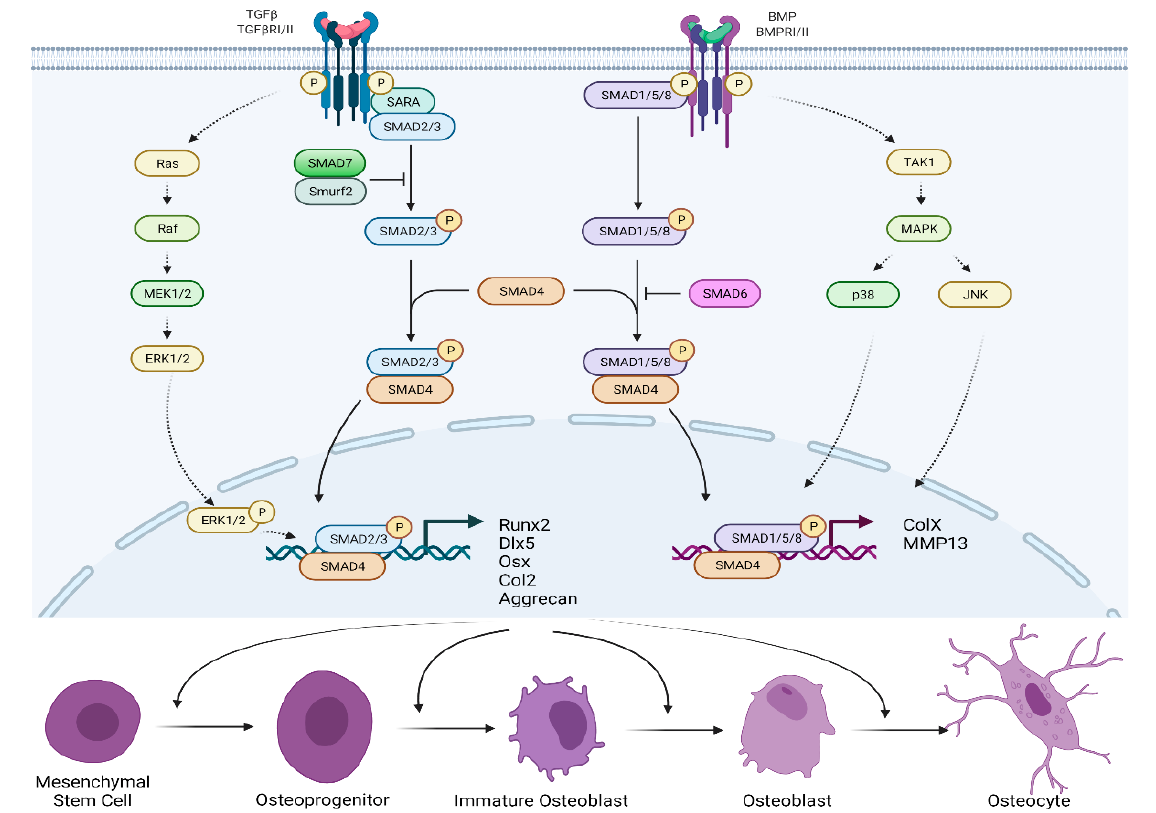
Figure 4. BMP/TGF- β signaling pathway for the formation of